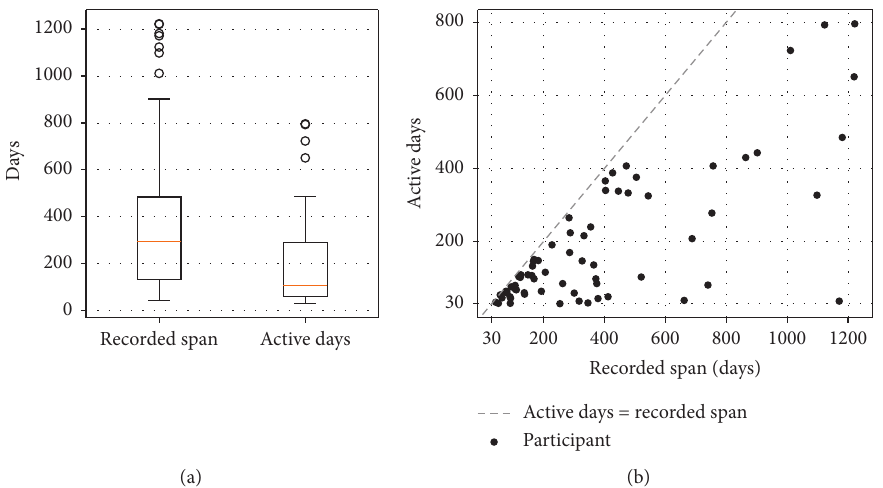
Figure 19: Range and distribution of travelers by their recorded date span and the number of their active days.